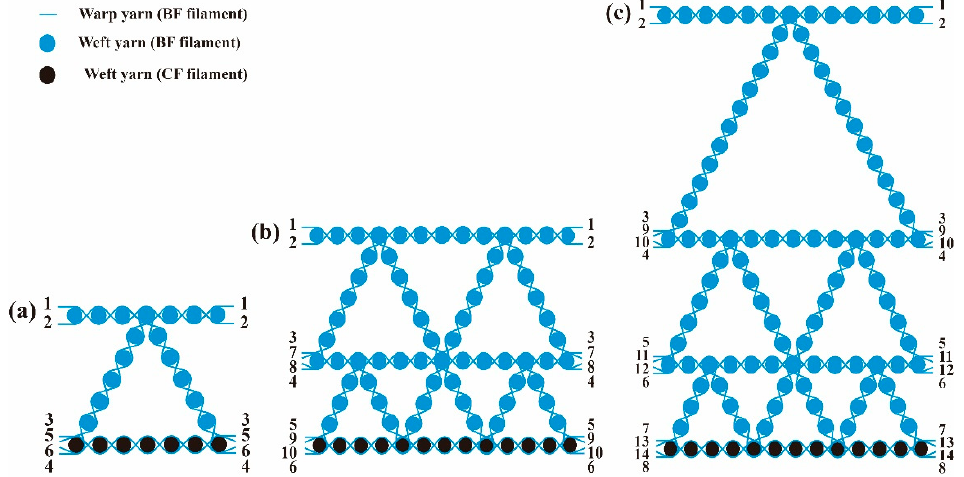
Figure 2. ( a ) Warp structural drawing of one-layer fabric; ( b ) warp structural drawing of two-layer fabric; ( c ) warp structural drawing of three-layer fabric.